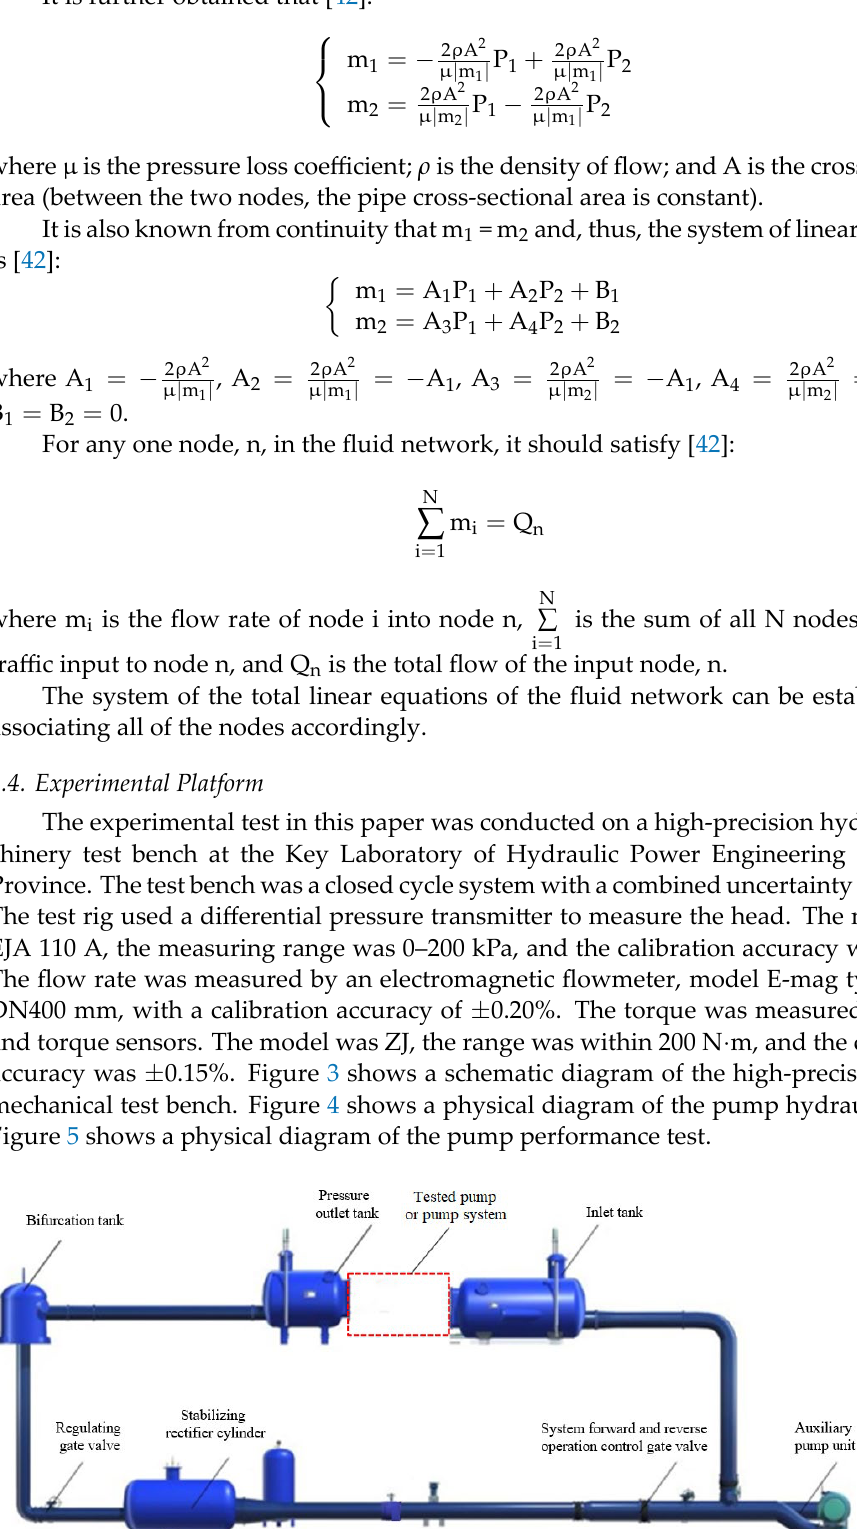
( b ) Guide Vane Figure 4. Physical diagram of the pump hydraulic model. Figure 5. Physical diagram of the pump performance experiment. 3. Simulation Model’s Construction and Validation 3.1. Simulation Model’s Construction This paper builds a simulation model based on Flowmaster software. Figure 6 shows a schematic diagram of the LAPS simulation model. Table 2 shows the names of the com- ponents representing the LAPS components. The component 1 pipe length was taken from the centerline length of the model’s inlet pipe, which was 10.62 m. The inlet channel from the inlet to the outlet uniformly took 25 sections and the weighted average of 25 sections for the diameter of the pipe for component 1, which was 2.82 m. The component 2 pipe length was taken from the centerline length of the model’s outlet pipe, which was 23.87 m. The outlet channel from the inlet to the outlet uniformly took 25 sections and the weighted average of 25 sections for the diameter of the pipe for component 2, which was 2.87 m. After the independence test of the calculation time step, 0.0025 s was selected as the time step of the transient calculation, and the total calculation time was 250 s.